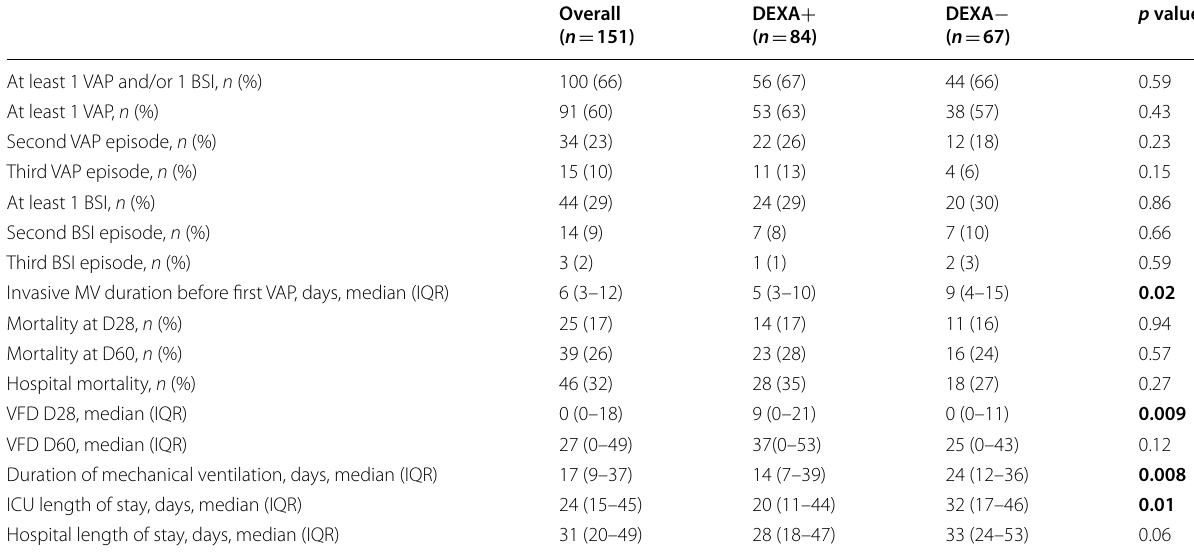
Table 2 Patients outcomes according to treatment with dexamethasone